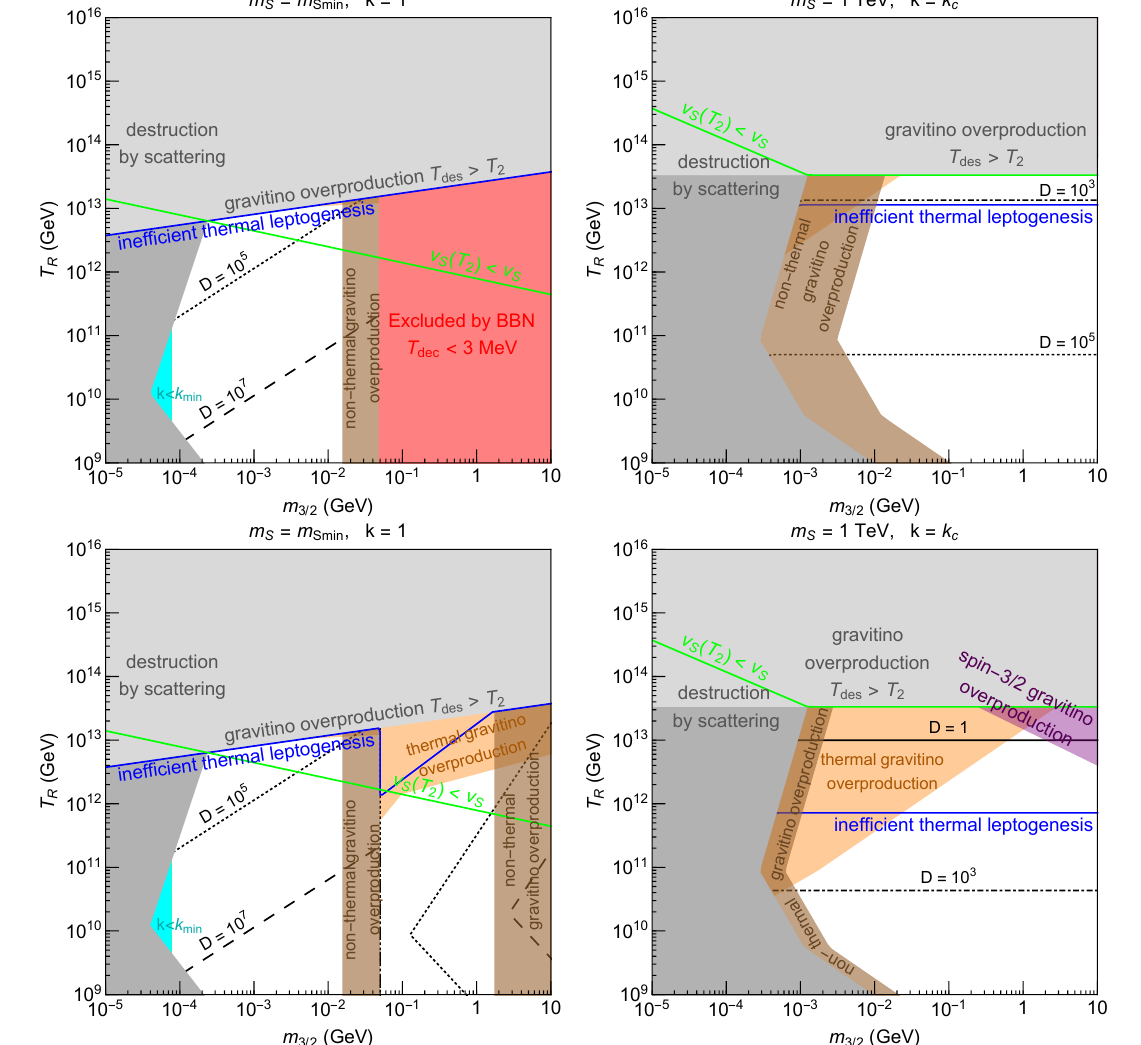
Figure 3 . The various constraints on the reheat temperature and the gravitino mass are shown as the shaded regions. The left (right) panels apply to the theories with (direct) indirect gauge mediation where the F term of S provides a full (small) amount of supersymmetry breaking. The sgoldstino condensate eventually decays to gluons (and Higgs/EW bosons) in the upper (lower) two panels. Leptogenesis can provide the observed baryon asymmetry above the blue contours. We take m 3 = 2